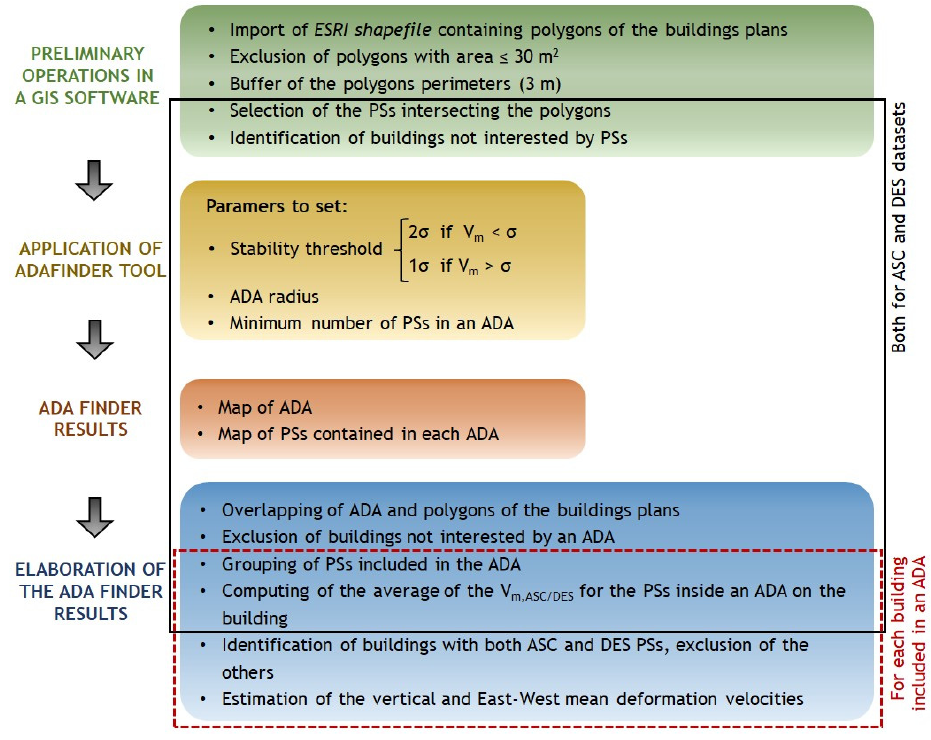
Figure 1. Flowchart of the proposed methodology.